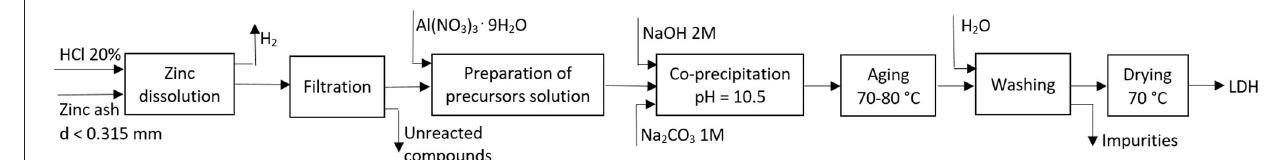
FIGURE 1 | Schematic procedure of Zn 2 Al–W sample preparation from zinc ash.